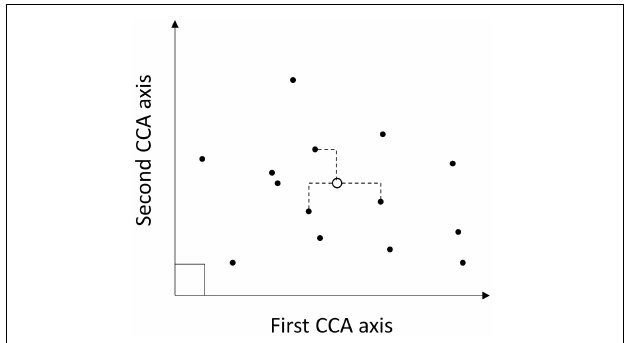
FIGURE 3 | Conceptual diagram highlighting the kNN imputation process for a simple case with two metrics (CCA axes) defining the feature space. After the CCA modeling (solid circles) are located in the feature space, then a pixel to be imputed (open circle) is placed in that space based on the auxiliary data (geospatial predictors). Distances from the focal pixel to all plots in the feature space are calculated and the k nearest neighbors are identified by minimizing those distances (indicated by dashed lines). Each of those nearest neighbors was imputed back to the pixel to populate a multiband raster, with the mean ALC for neighbors across bands being the predicted ALC for the